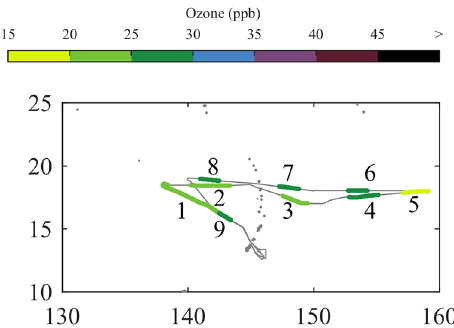
Figure 17. Flight track of RF03 with each profile coloured by mean tropospheric ozone as in Fig. 12. Cyclone Faxai was situated at ∼ 20 ◦ N, 150 ◦ E during this flight (see Fig.